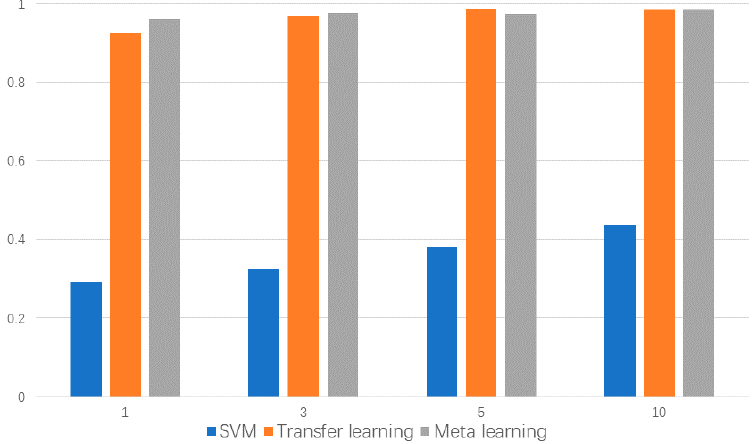
Figure 7. Accuracy comparison on PU bearing dataset.